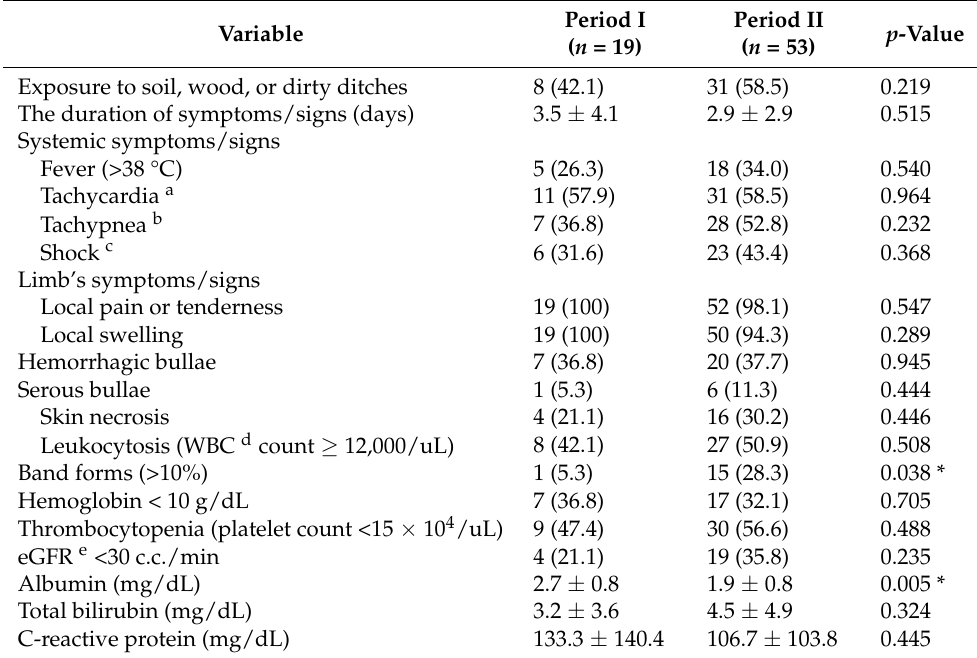
Table 5. Comparison of clinical presentations and important laboratory findings of 72 patients with Aeromonas NF between periods I and